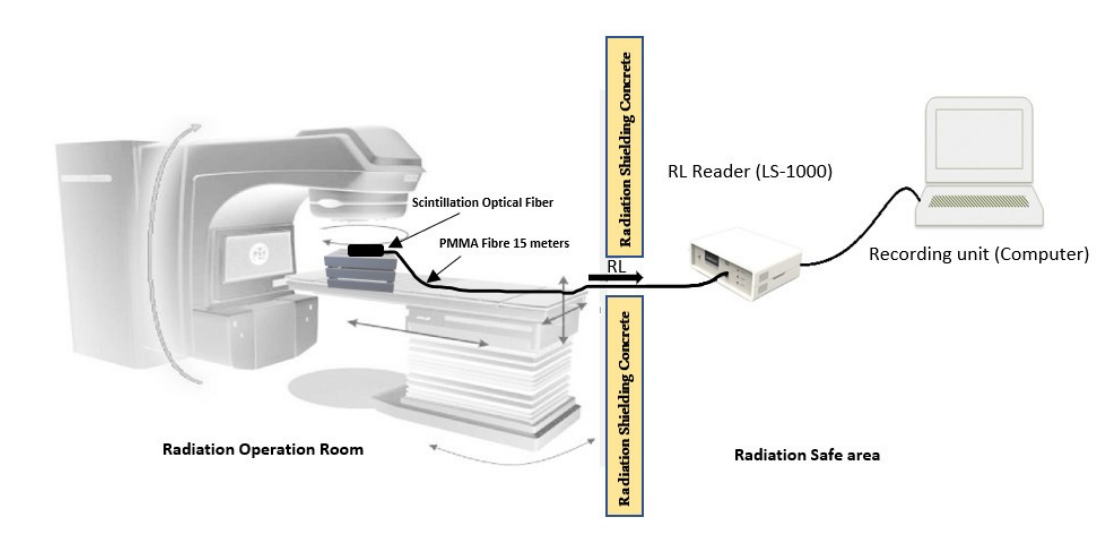
Figure 4. Experimental setup used for dosimetric characterization.